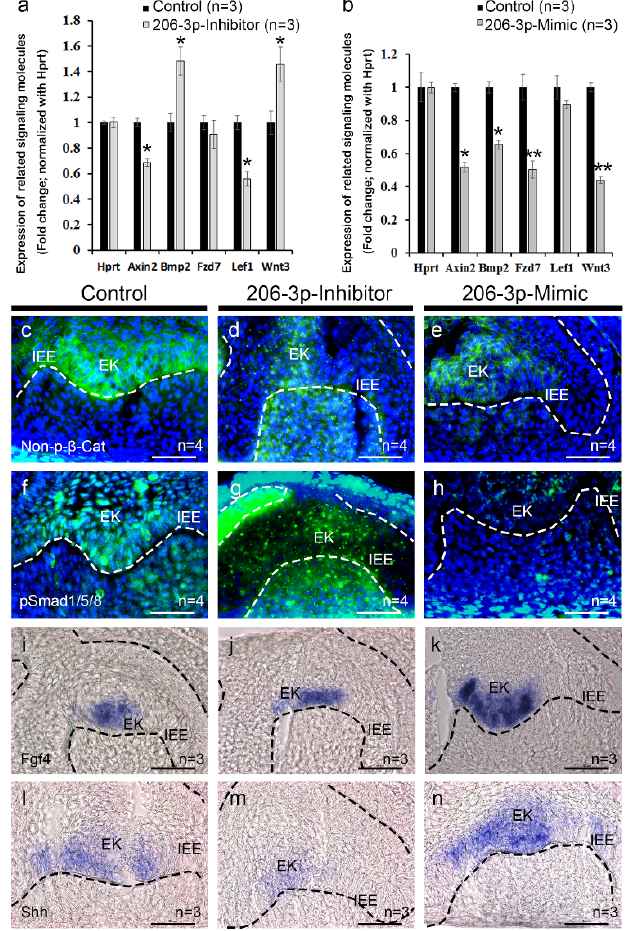
Figure 4. Altered signaling after loss or gain of function of miR-206-3p . Signaling factors related to tooth development were examined by qPCR ( a – b ). The expression of active β-catenin was reduced, and the localization patterns in the IEE and EK were destroyed after inhibiting miR-206-3p ( d ) compared with those in the control ( c ). However, a stronger mesenchymal expression of β-Catenin was observed ( d ). The specimen treated with the miR-206-3p mimic showed weaker expressions of β-catenin in the IEE and EK ( e ). The epithelial and mesenchymal expressions of pSMAD1/5/8 were reduced, and the localization patterns were impaired upon inhibition of miR-206-3p during the in vitro organ cultivation ( g ) compared with those in the control ( f ). The specimen treated with the mimic showed reduced expression of pSMAD1/5/8 in both, the epithelium and mesenchyme ( h ). FGF4 expression was detected within a restricted area in the EK of the control specimen ( i ). However, the expression was expanded in the IEE after inhibiting miR-206-3p ( j ). The specimen treated with the mimic showed an increased and expanded expression of Fgf4 in the EK ( k ). Similarly, the Shh expression was decreased after the inhibition of miR-206-3p ( m ) compared with that in the control ( l ) but was increased in the specimens treated with the mimic ( n ). Dotted lines indicate the epithelial boundary ( c – n ). EK; enamel knot, IEE; inner enamel epithelium. Scale bars 50 µm ( c – n ). * and ** indicate not signigicant, p < 0.05 and p < 0.01, respectively. Scale bars 50 µm (c–n). The β-catenin is reported to have role in tooth development from early placode to late bell stage [5] and tooth root formation [28] and nuclear β-catenin is used as an alternate readout for Wnt signaling activity [29]. In control ( n = 4), the β-catenin was localized both in the nuclear and cytoplasmic regions of EK and adjacent cells in the mesenchyme (Figure 4c). In contrast, the protein